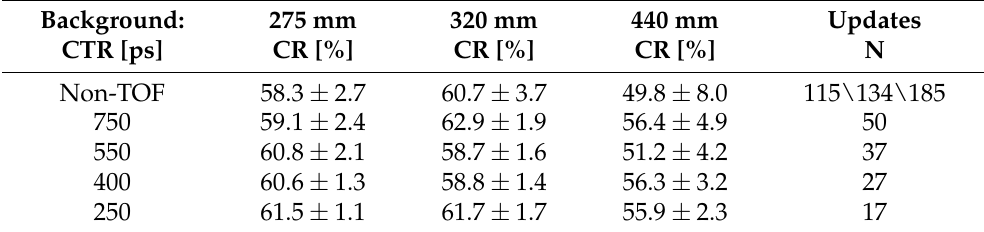
Table 2. Contrast recovery using the proposed rule for the 10 mm sphere with β = 2.0 contrast, as a function of CTR and background diameter, aiming at matching to 50 updates at 750 ps. Values reported as mean ± one standard